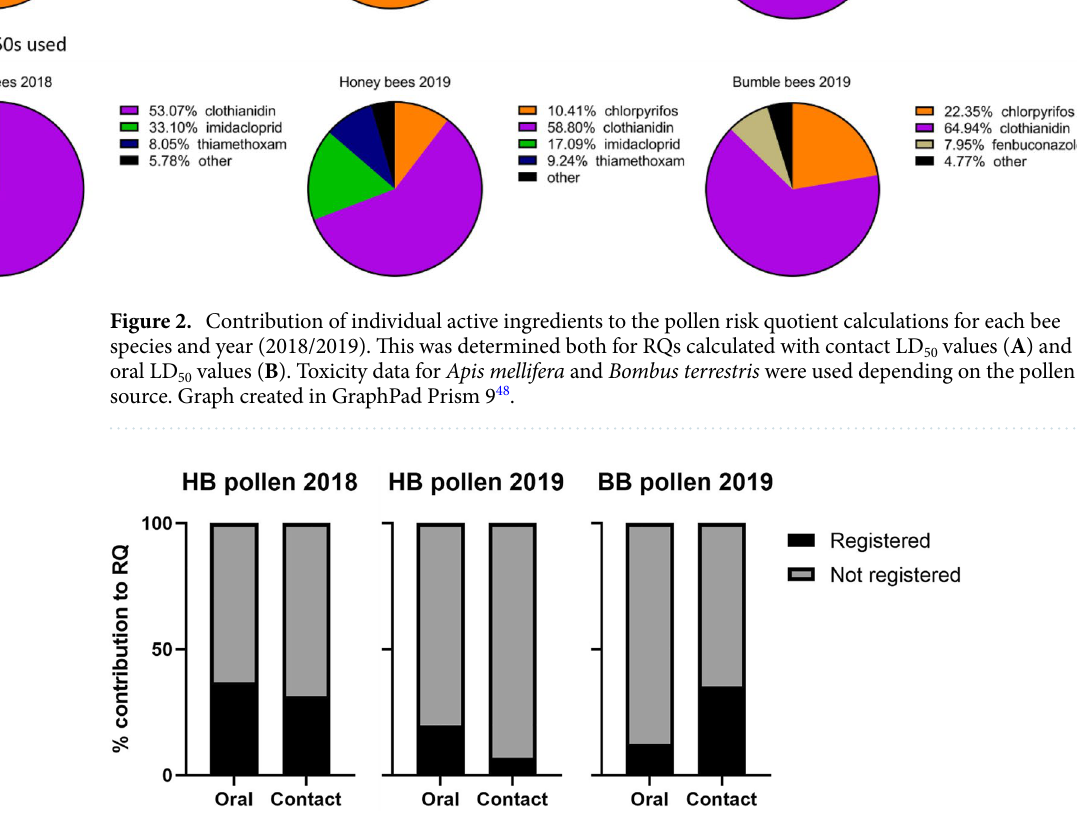
Figure 3. Contribution of pesticide active ingredients to pollen risk quotient values based on whether they are registered for use on blueberries, or not. A product was considered registered for use on blueberries if the label indicated it is permitted to be applied to blueberry bushes at any time of the year. RQs were calculated with contact LD 50 values and oral LD 50 values. Toxicity data for Apis mellifera and Bombus terrestris were used depending on which species collected the pollen (HB-honey bees, Apis mellifera , BB-bumble bees, Bombus impatiens ). Graph created in GraphPad Prism 9 48